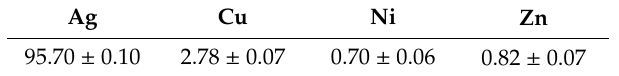
Table 1. Ag-Cu-Ni-Zn alloy composition; each element concentration is expressed in (wt